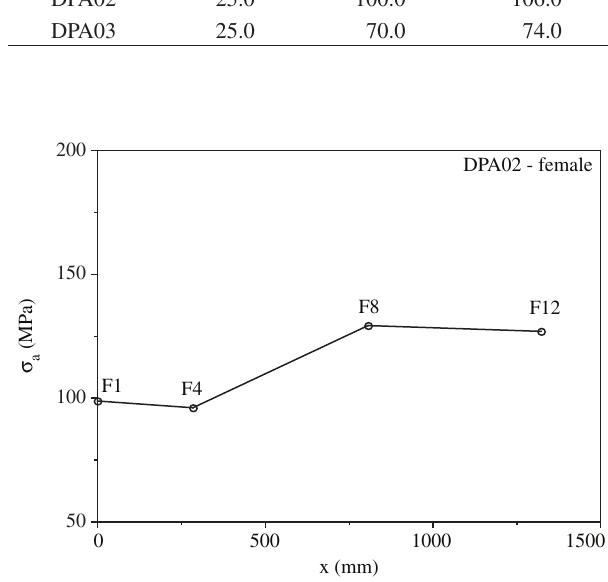
Figure 5. Typical set of data from a preliminary load test for DPA02 (pin